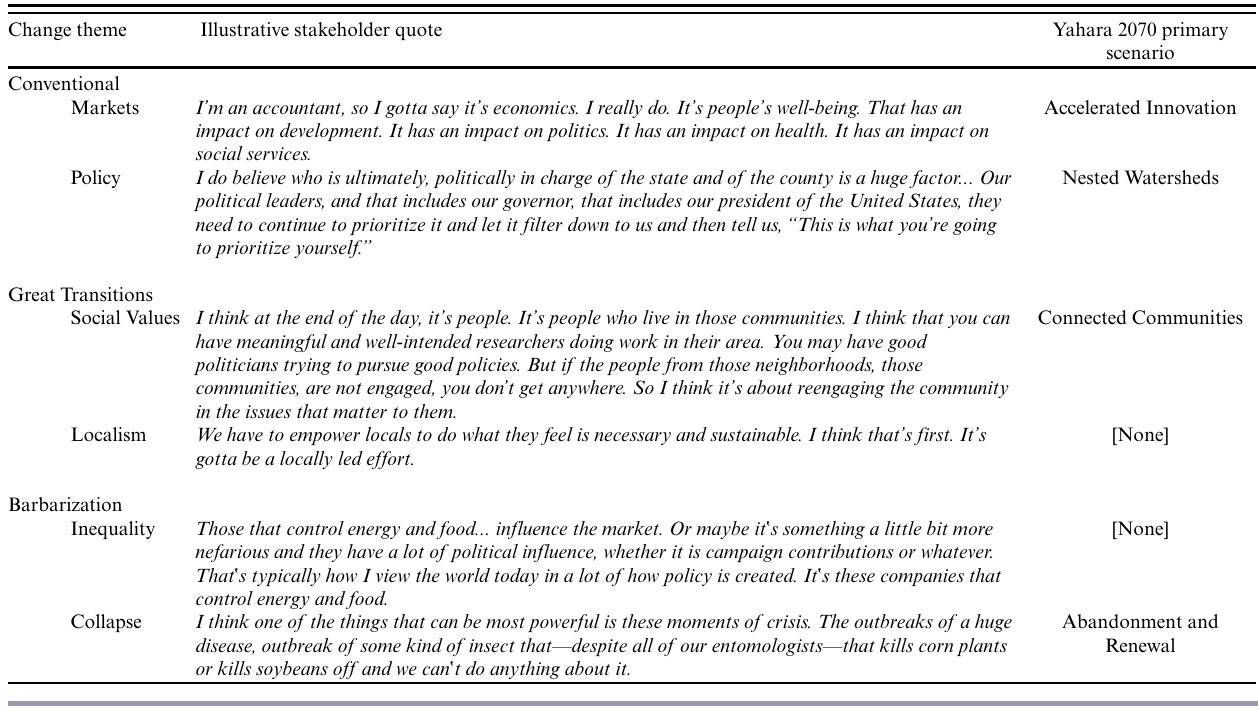
Table 2 . Scenario change themes, with illustrative interview excerpts, and primary Yahara 2070 scenario associated with each